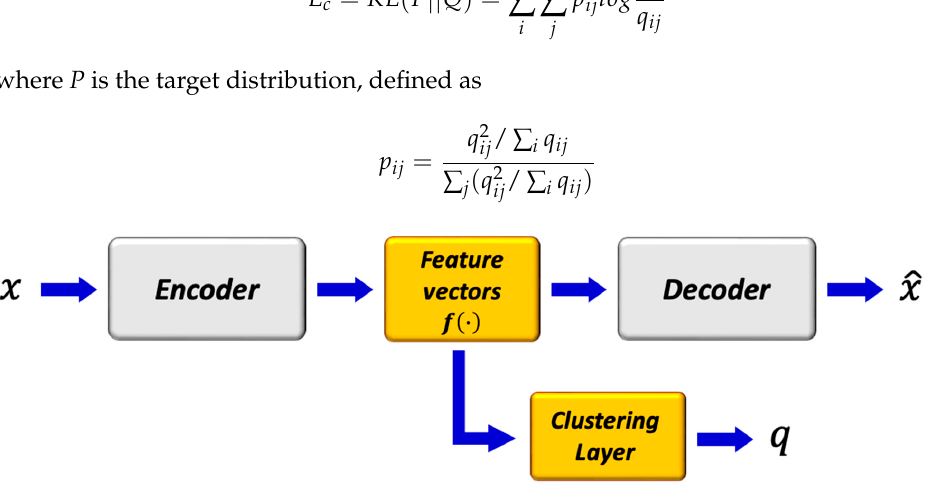
Figure 6. Structure of deep convolutional embedded clustering. The architecture consists of convolu- tional auto-encoders and a clustering layer connected to the embedded layer of the auto-encoders. The γ = 0.1 parameter was set, and the DCAE’s weights, cluster centers, and target distribution, P , were fine-tuned. The target distribution, P , serves as the GT soft label but also depends on the predicted soft label. Therefore, to avoid instability, P should not be updated at each iteration using only a batch of data. The target distribution was updated using all embedded points every T = 200 iterations. The training process was terminated if the change of label assignments between two consecutive updates for target distribution was less than a threshold of δ =